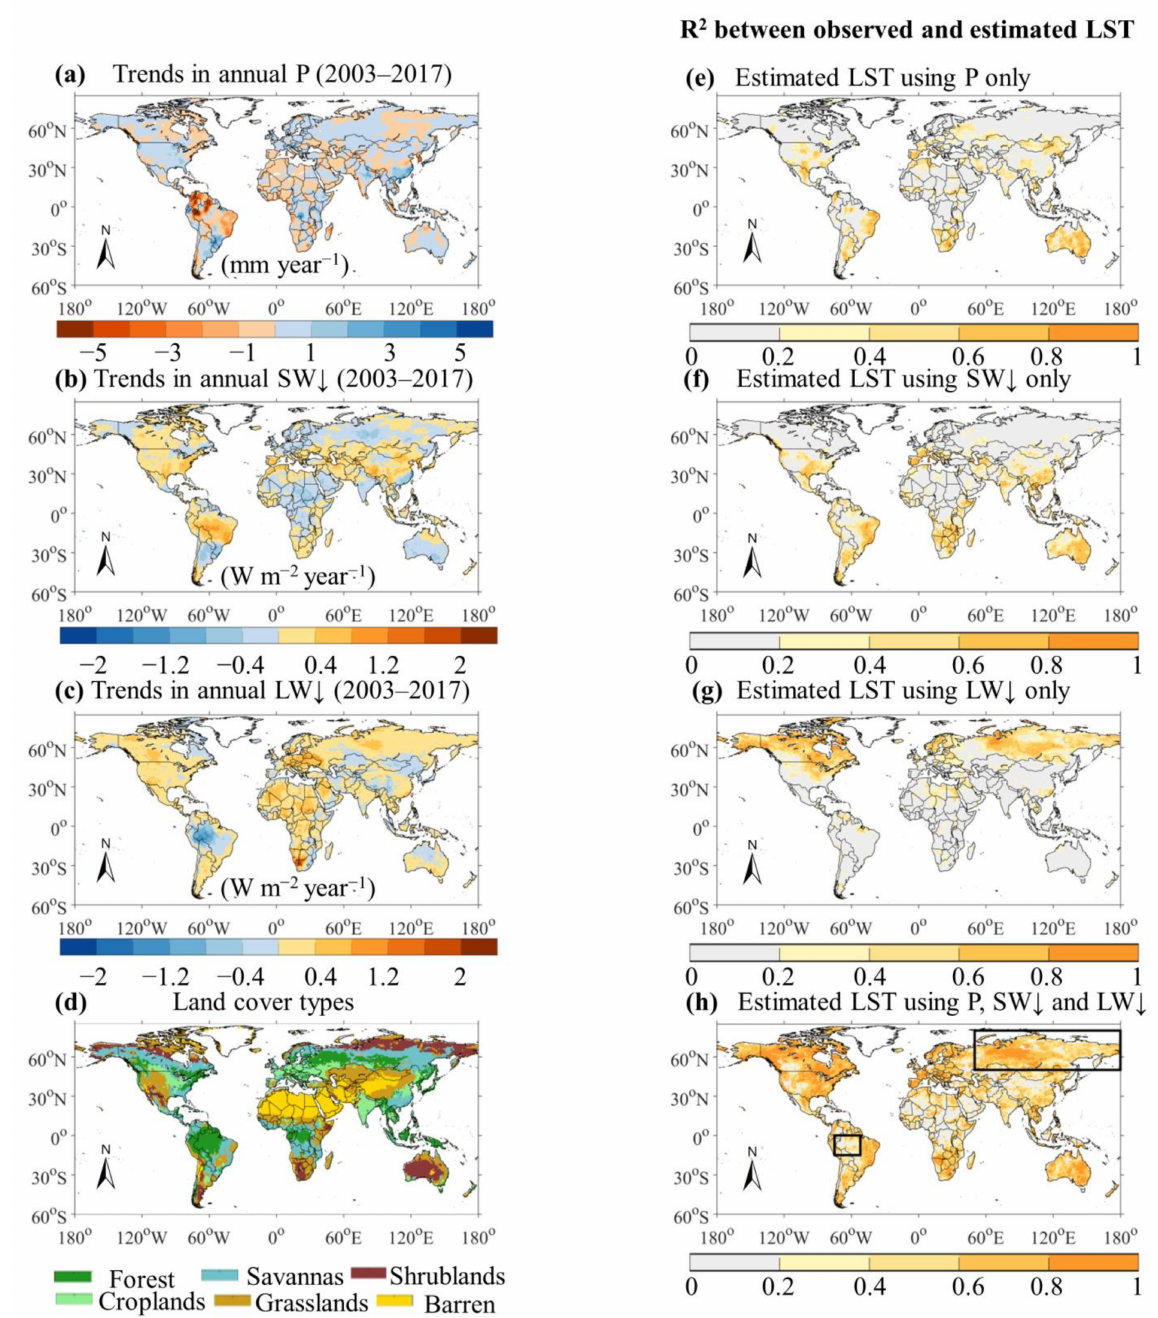
Figure 3. ( a – c ) Spatial patterns of trends in annual P, SW ↓ , and LW ↓ during 2003–2017. ( d ) Spatial distribution of major land cover types based on the MODIS IGBP classification map. ( e – g ) Spatial distribution of the coefficients of determination (R 2 ) between annual AIRS LST and estimated LST using ( e ) precipitation (P), ( f ) incoming surface solar radiation (SW ↓ ), ( g ) incoming surface longwave radiation (LW ↓ ), and ( h ) all three combined (representing the independent variable set in the regression model). LST changes within the two selected black rectangles ( panel h ) are further examined at a monthly time scale. Based on the trend analysis, regression analyses of P, SW ↓ , LW ↓ , and AIRS LST